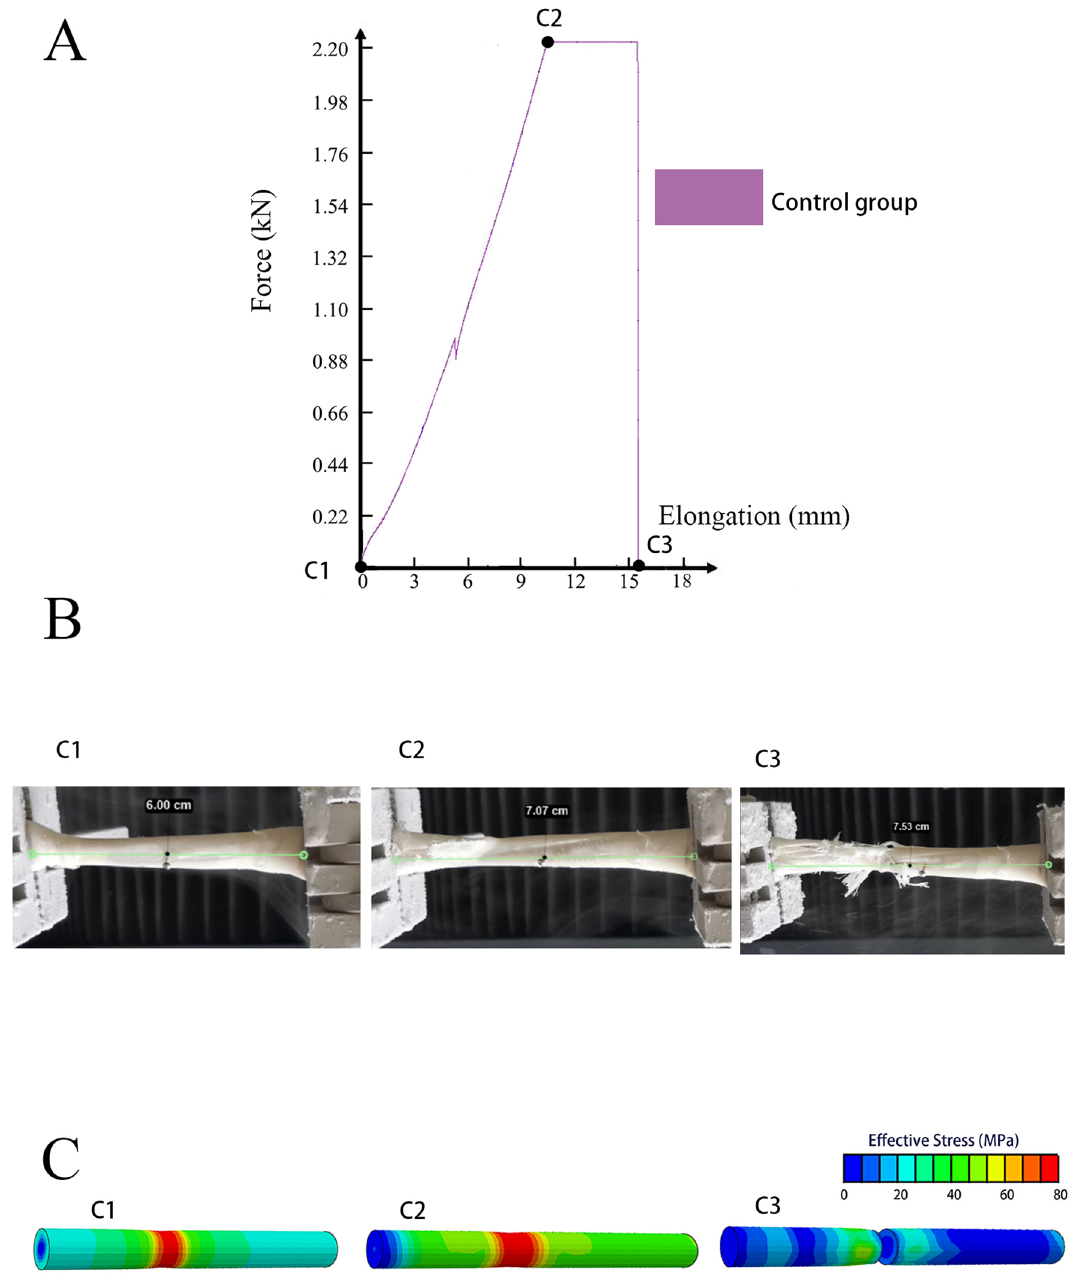
Figure 4. Motion analysis of the intact tendon (Group C). ( A ) The F-L curve. The black spots on the curve represent before the test (C1), when the failure load was reached (C2), and when the tendon was divided into two parts (C3). The tendon stress was gradually increased until the failure load was reached (C2). Subsequently, tendon stress was maintained at the failure load. After the tendon was elongated by approximately 5 mm, the stress rapidly decreased to zero (C3). ( B ) Video screenshots before the test (C1), when the failure load was reached (C2), and when the tendon was divided into two parts (C3). The length of the tendon test area was 6 cm before beginning the tensile test (C1). Subsequently, the tendon was lengthened at a uniform speed. When the failure load was reached, a small rupture appeared on the tendon surface (C2), followed by tendon fiber disintegration. The ruptured surface was uneven and the tendon was broken into two parts (C3). ( C ) FEM of the tendon before the test (C1), when the failure load was reached (C2), and when the tendon was nearly divided into two parts (C3). The figure shows the stress distribution in tendons. Red indicates the greatest stress, and blue indicates the lowest stress. When the tendon was stretched, the internal stress of the tendon increased, and the stress was concentrated in the test area (C2). The point with the highest stress level was the position of tendon